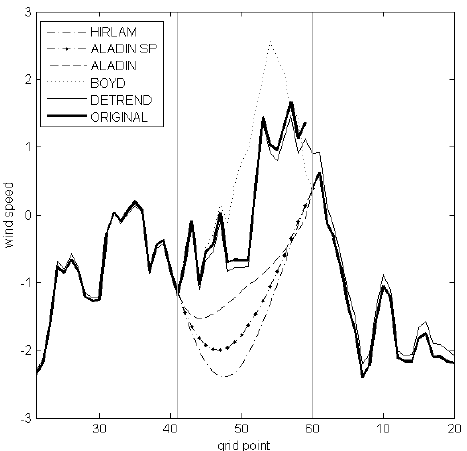
Figure 3. One-dimensional periodization of an arbitrary wind field for the discussed methods except for DCT. The thin grey lines de- note the borders of the extension